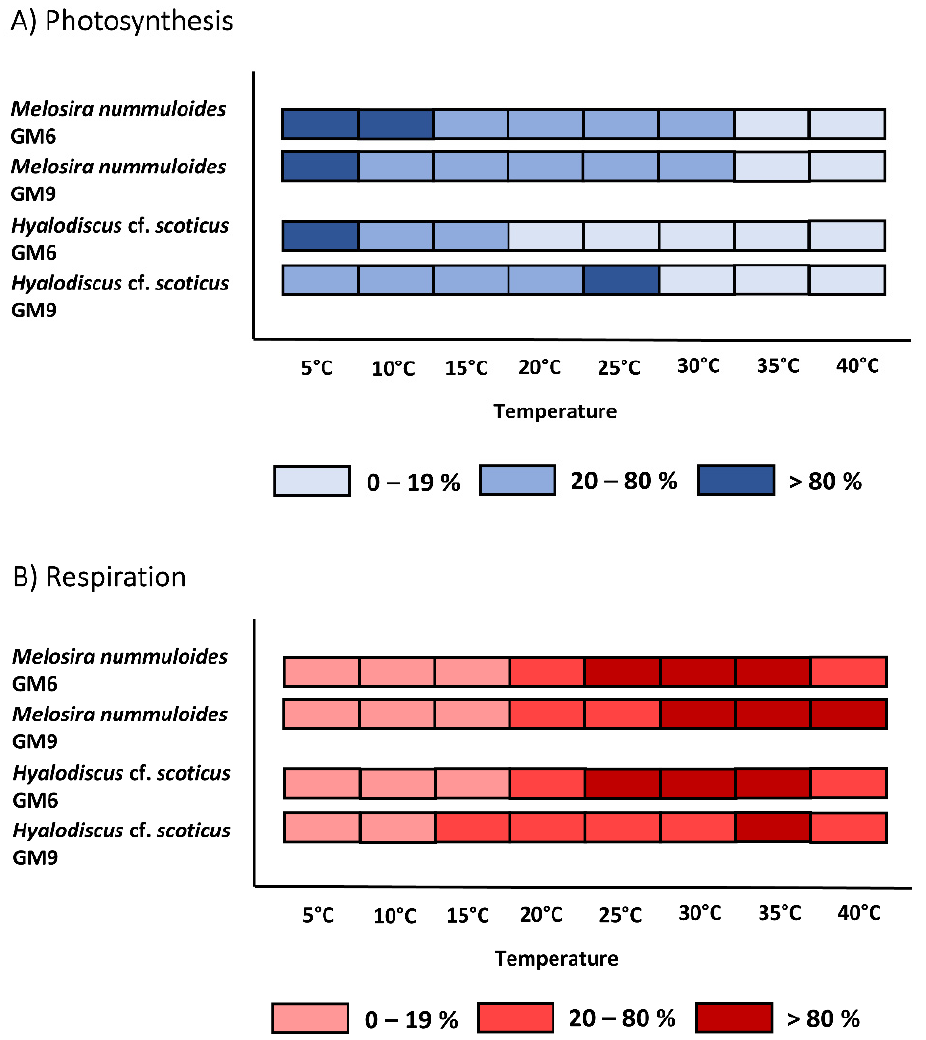
Figure 7. Effect of temperature on ( A ) photosynthetic oxygen evolution and ( B ) respirational oxygen consumption of two Baltic Sea benthic diatom strains in two different cultivation media (GM6 and GM9). Dark blue/red symbols represent highest photosynthesis at >80% percentile, medium blue/red symbols within 20 and 80% percentile and light blue/red symbols < 20% percentile. Data represent mean values (n = 3).